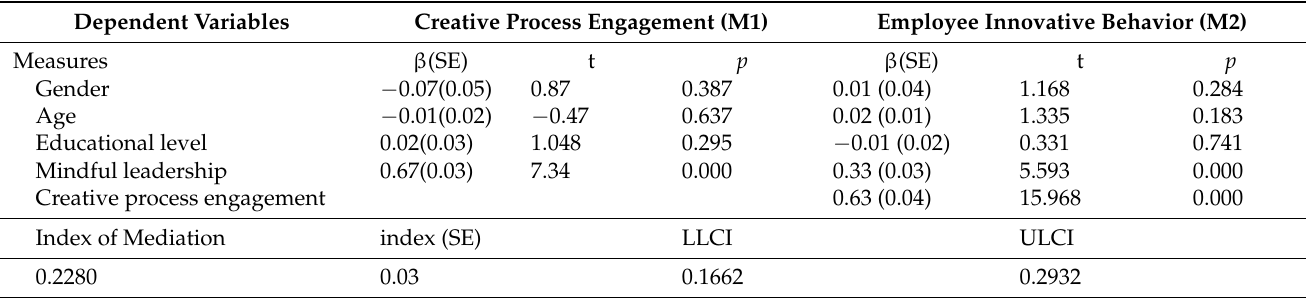
Table 3. Hierarchical regression results of main effect and mediating effect.